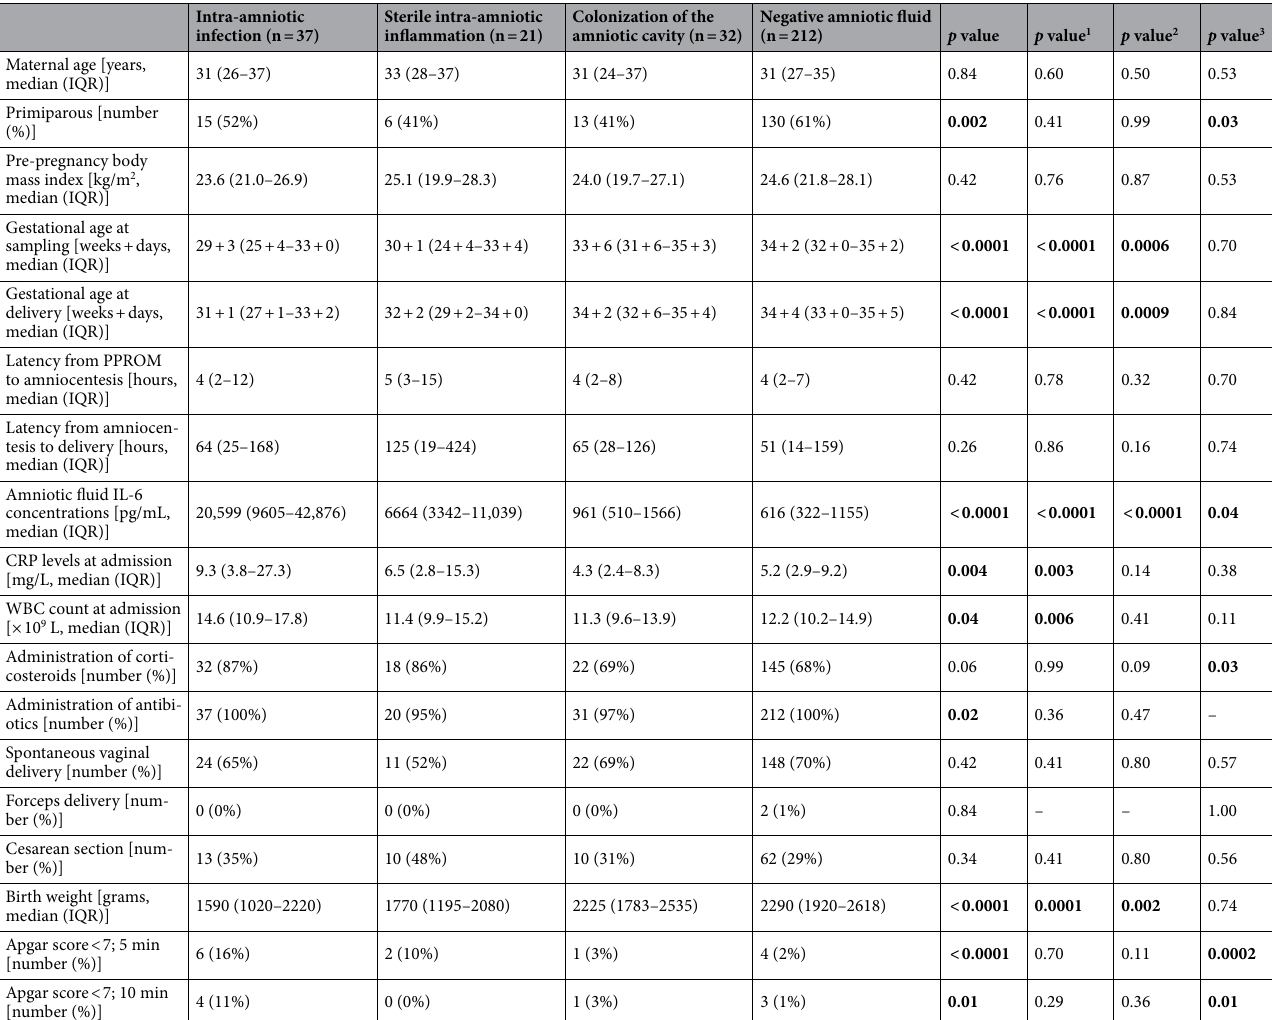
Table 2. Demographical and clinical characteristics of women with preterm prelabor rupture of membranes with respect to the presence of intra-amniotic infection, sterile intra-amniotic inflammation, colonization of the amniotic cavity and negative amniotic fluid. Abbreviations: CRP: C-reactive protein, IL: interleukin, WBC: White blood cells. Continuous variables were compared using a nonparametric Kruskal–Wallis or Mann– Whitney U test. Categorical variables were compared using chi-square test or Fisher’s exact test. Statistically significant results are marked in bold. Continuous variables are presented as median (interquartile range) and categorical as number (%). p value—comparison among women with intra-amniotic infection, with sterile intra-amniotic infection, with colonization of the amniotic cavity, and with negative amniotic fluid. p value 1 — comparison between women with colonization of the amniotic cavity and with intra-amniotic infection. p value 2 —comparison between women with colonization of the amniotic cavity and with sterile intra-amniotic inflammation. p value 3 —comparison between women with colonization of the amniotic cavity and